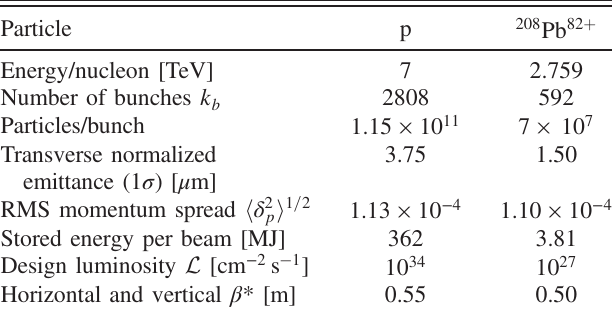
TABLE I. Design parameters for the LHCs proton (p) and lead ion ( 208 Pb 82 þ ) beams in collision conditions. The luminosity L is a measure of the number of collisions that can be produced at the experiments and the β * refers to the optical amplitude function β at the collision points